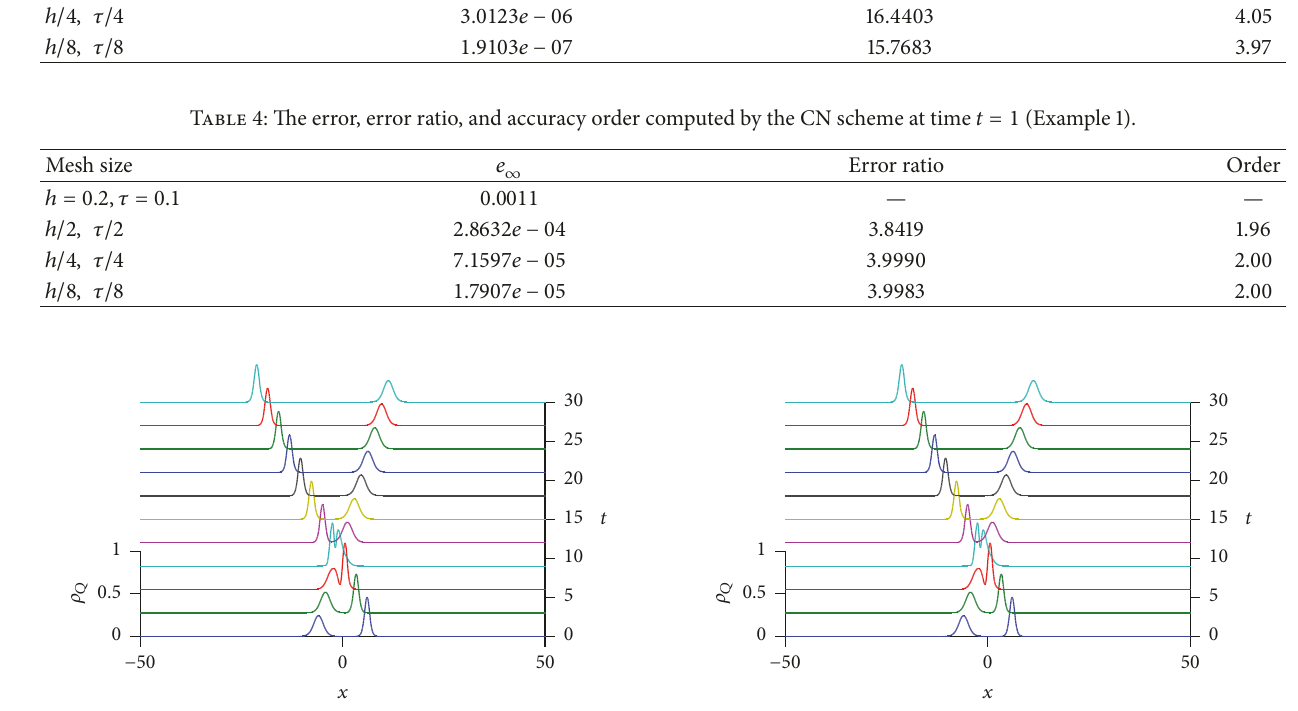
Figure 1: The time evolution of the charge density at 푥 = 0 by using the CM-IIF2 scheme with ℎ = 0.05 and 휏 = 0.01 (Example 2).